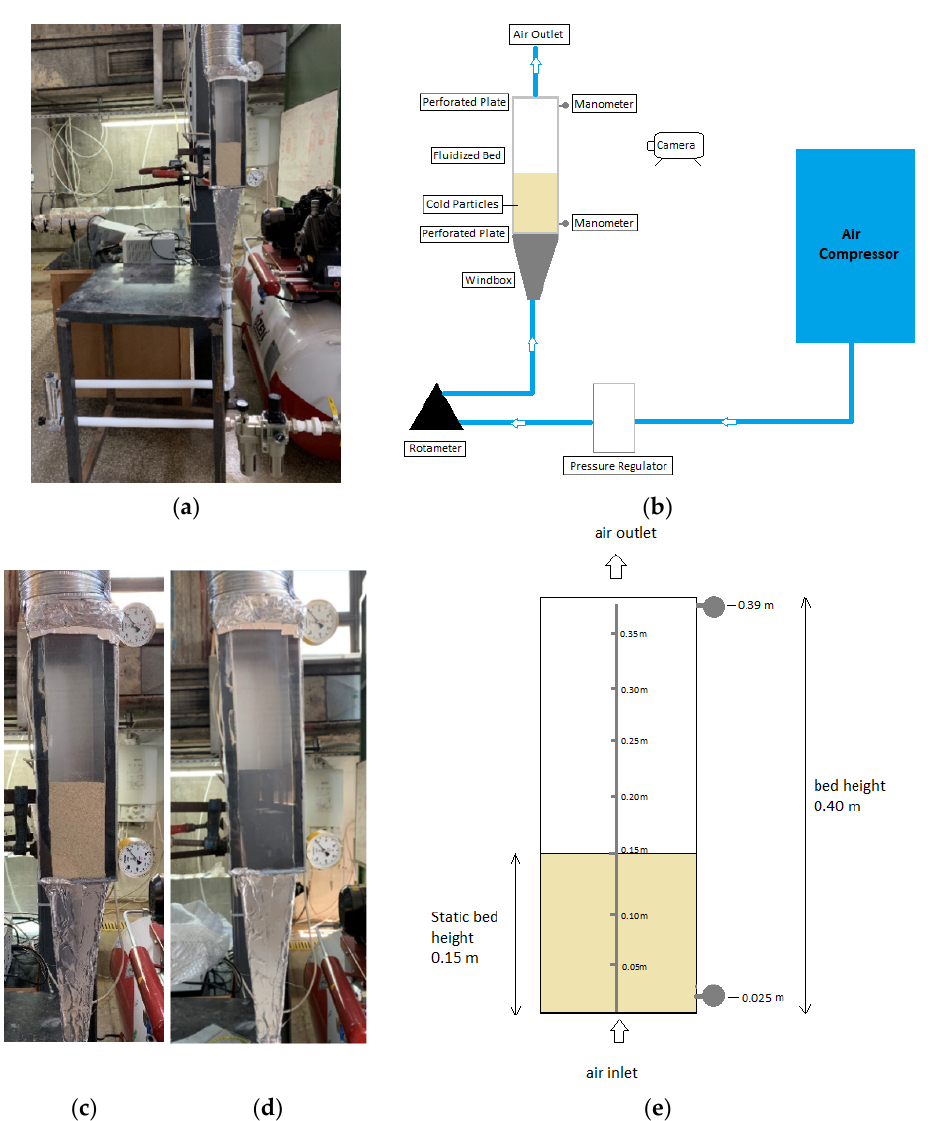
Figure 1. ( a ) Snapshot of the hydrodynamics experimental setup; ( b ) diagram of the operation in the hydrodynamic experimental setup; ( c ) snapshot of the sand-filled bed; ( d ) snapshot of the CARBOHSP-filled bed; ( e ) schematic drawing of the bed.